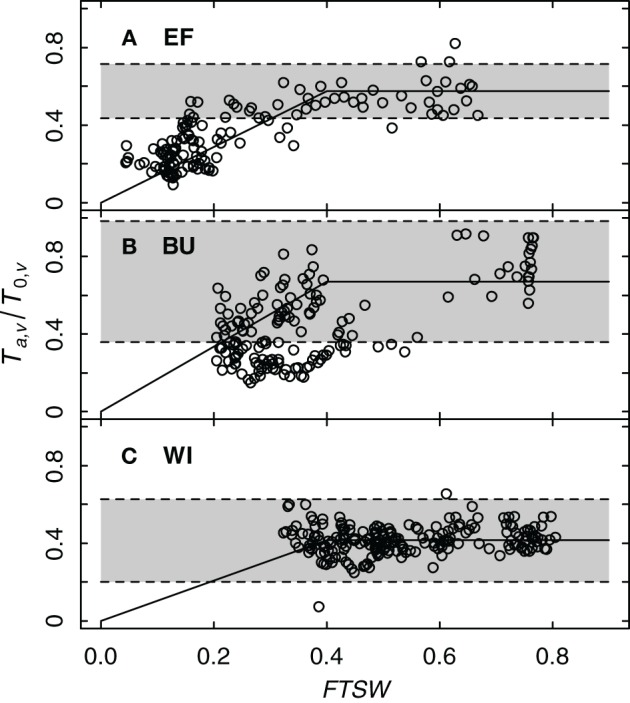
Relative grapevine transpiration (Ta,v/T0,v) as a function of FTSW for three vineyards (EF, BU, WI; A–C). The shaded background indicates the confidence interval of Ta,v/T0,v, where transpiration is not limited by insufficient water supply (resulting from sap flow data of six vines per vineyard for the years 2011 and 2012). The solid line shows a bilinear function describing the feedback of water stress on relative grapevine transpiration with a threshold value of 0.4.